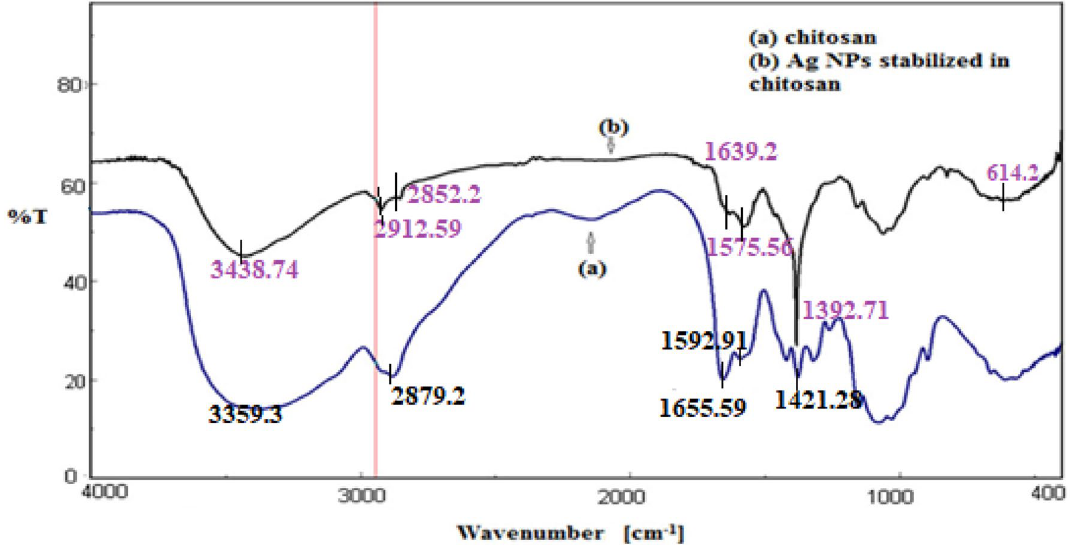
Figure 8. FTIR spectra of pure Chitosan and the prepared silver nanoparticles stabilized in Chitosan.